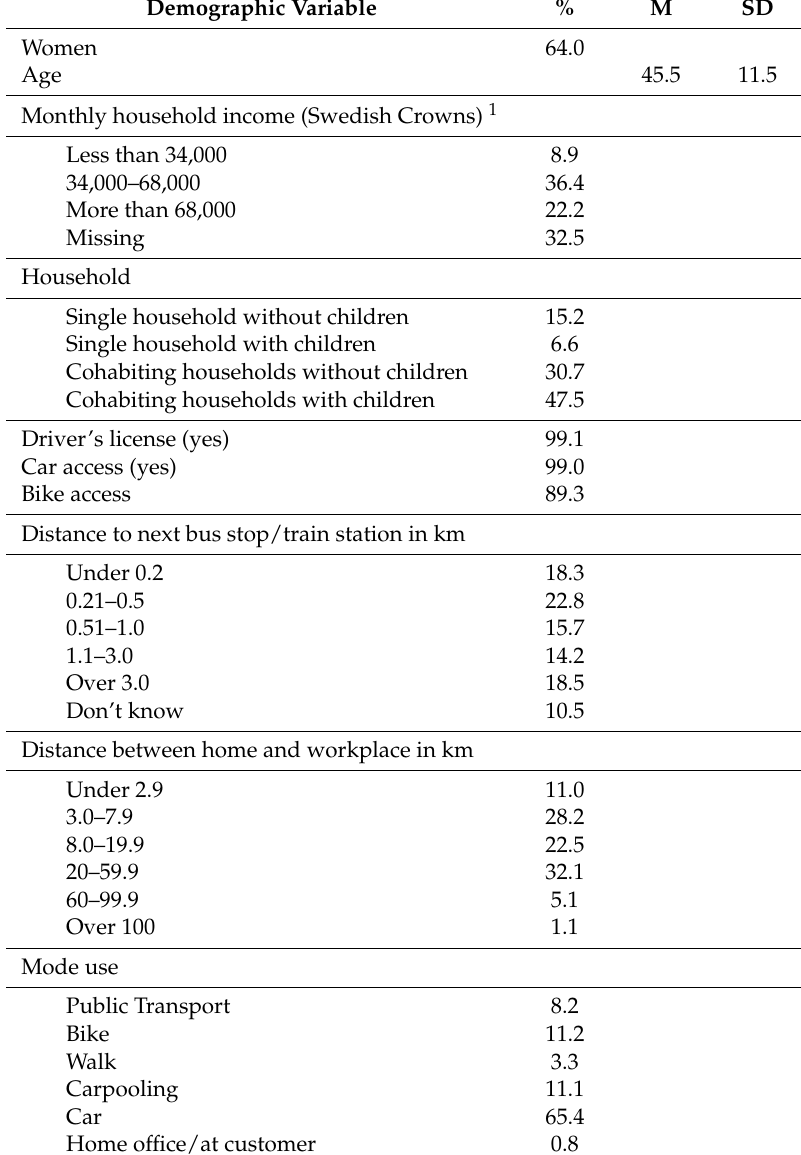
Table 2. Descriptives of the analytic sample ( n =